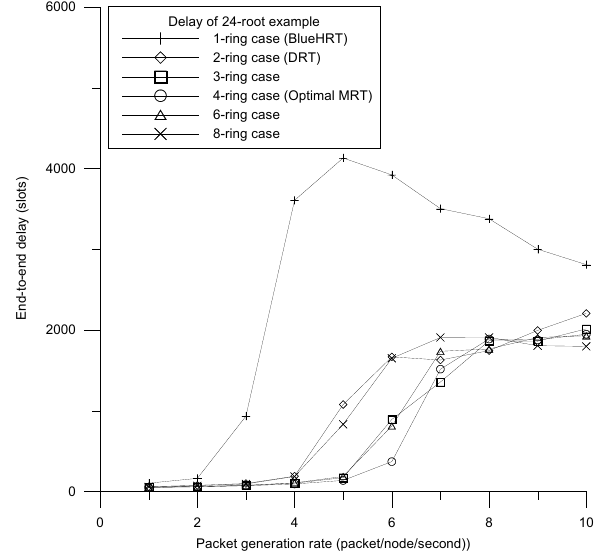
Figure 11. Average packet delay of the Optimal MRT, DRT, and